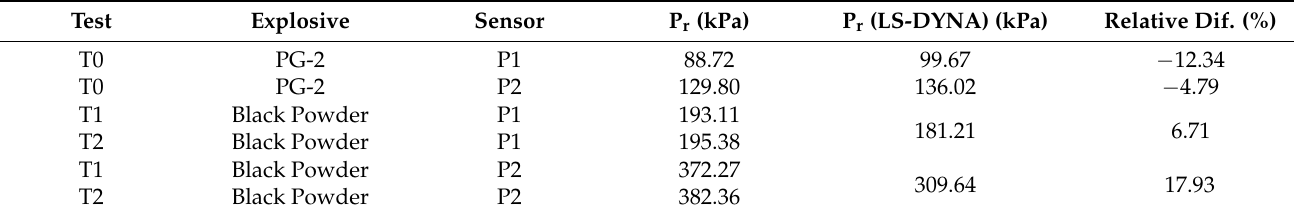
Figure 7. Sequence of images obtained with HSC in trial T7: PG2. Time in milliseconds; the reference time is the first frame of the video where the detonation is observed. Table 4. Pressure sensor results. Friedlander